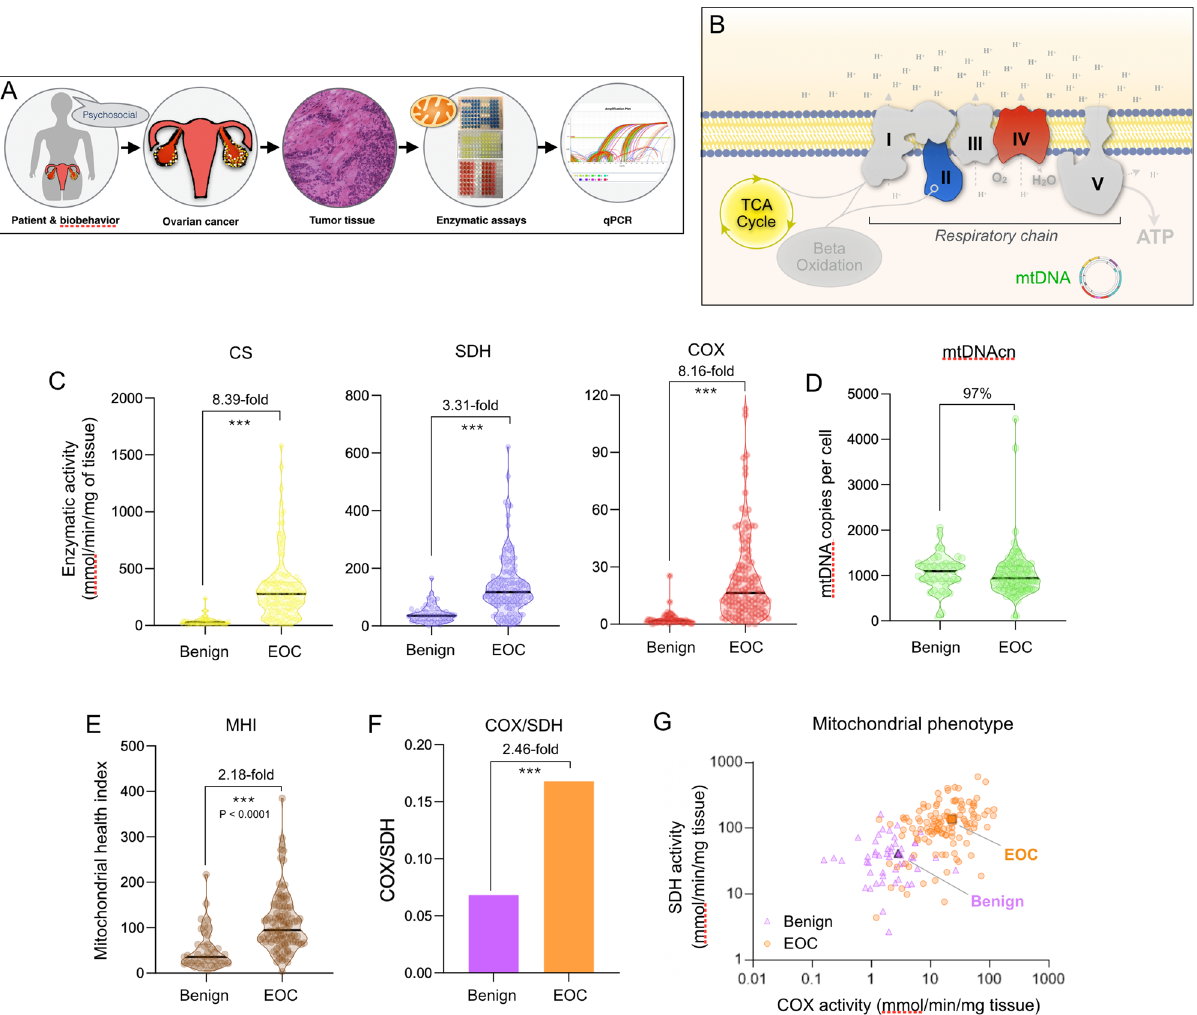
Figure 2. Mitochondrial profiling in benign and epithelial ovarian carcinoma (EOC) tissue. ( A ) Overview of the study design illustrating the multi-level approach ranging from biobehavioral factors to biochemical and molecular assessments of mitochondrial content and function. ( B ) Schematic of the internal components of the mitochondrial respiratory chain (complexes I-V), the tricarboxylic acid (TCA, also Krebs) cycle, and the mitochondrial genome (mtDNA). Enzymatic activities measured include citrate synthase (CS), succinate dehydrogenase (SDH, complex II), and cytochrome c oxidase (COX, complex IV). mtDNA copy number (mtDNAcn) was measured using qPCR. Using this data, the Mitochondrial Health Index (MHI) was calculated for each patient with mean-centered activities of respiratory chain complexes, divided by markers of mitochondrial content 3 . ( C ) Enzymatic activities for CS, SDH, and COX, ( D ) mtDNAcn, and ( E ) MHI. ( F ) Average COX/SDH ratio and ( G ) scatterplot illustrating the distinct mitochondrial phenotypes between benign vs EOC. Each data-point represents the average of two measures for a participant; graphed on Log10 scale. n = 51 benign, n = 128 high-grade EOCs, P values from one-way ANOVA performed on log-transformed data. *** p < 0.001. The non-transformed data is